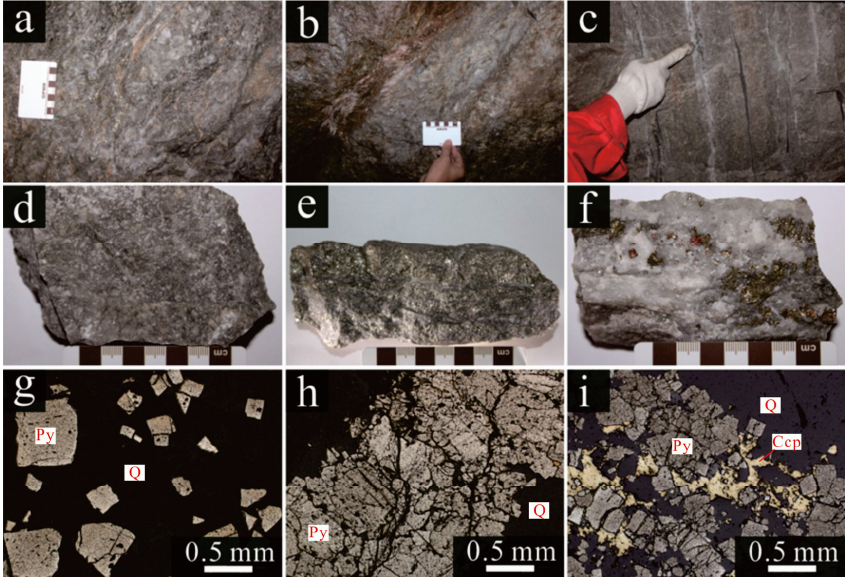
Figure 4. Photography of the three styles of ores: ( a , d ) Disseminated-stockwork style; ( b , e ) Auriferous quartz vein style; ( c , f ) sulfide-quartz veinlet in K-feldspar alteration granite; and ( g – i ) photomicrographs in the reflected light of the disseminated-stockwork type, auriferous quartz vein style and sulfide-quartz veinlet in K-feldspar alteration granite, respectively.